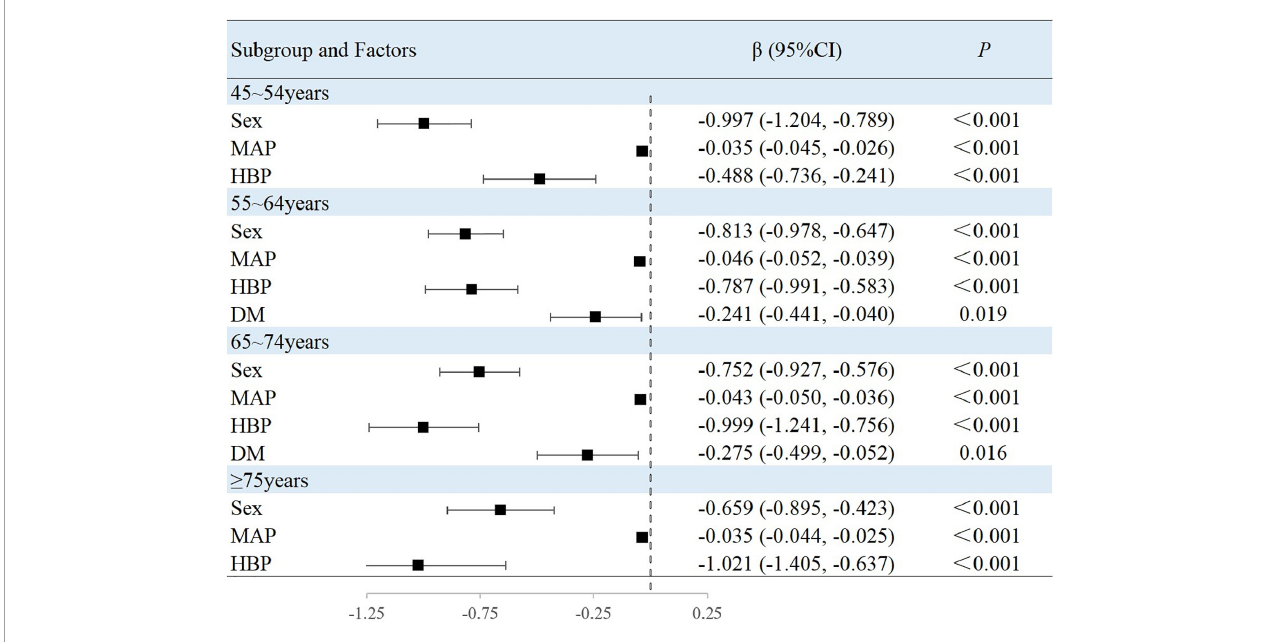
FIGURE4 Factors associated with BAD in subgroup analysis by age.